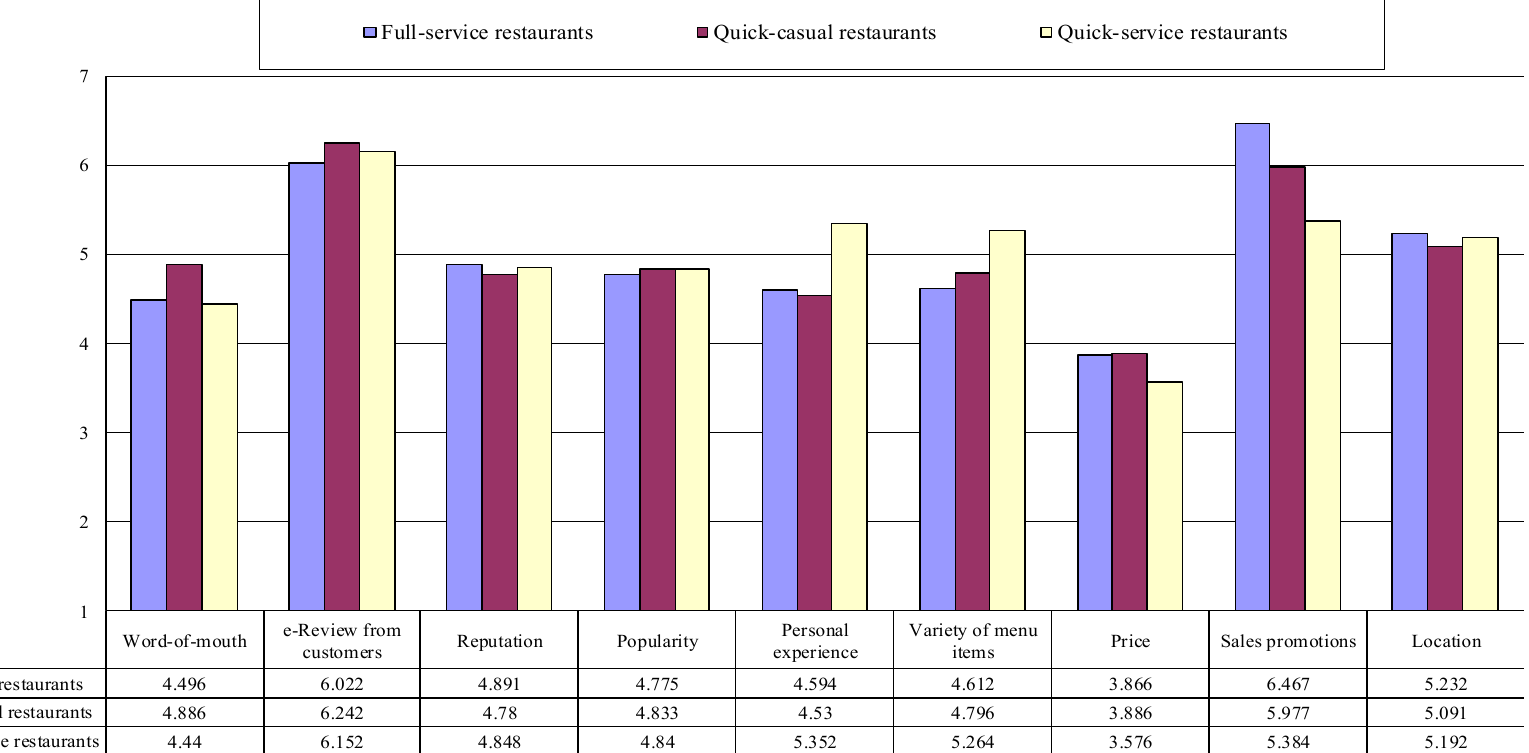
Figure 3. Ranking by restaurant types. 1: “The most important criteria to consider when choosing a restaurant”; 7: “The least important criteria to consider when choosing a restaurant”. Full-service restaurants ( n = 276), Quick-casual restaurants ( n = 132), Quick-service restaurants ( n =